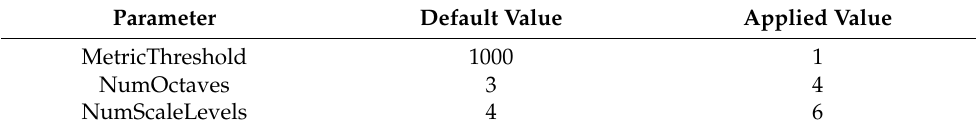
Table 2. Default and applied values of the parameters of the detectSURFFeatures function used in the registration of the images acquired with the MicaSense ® RedEdge camera. Parameter Default Value Applied Value MetricThreshold 1000 1 NumOctaves 3 4 NumScaleLevels 4